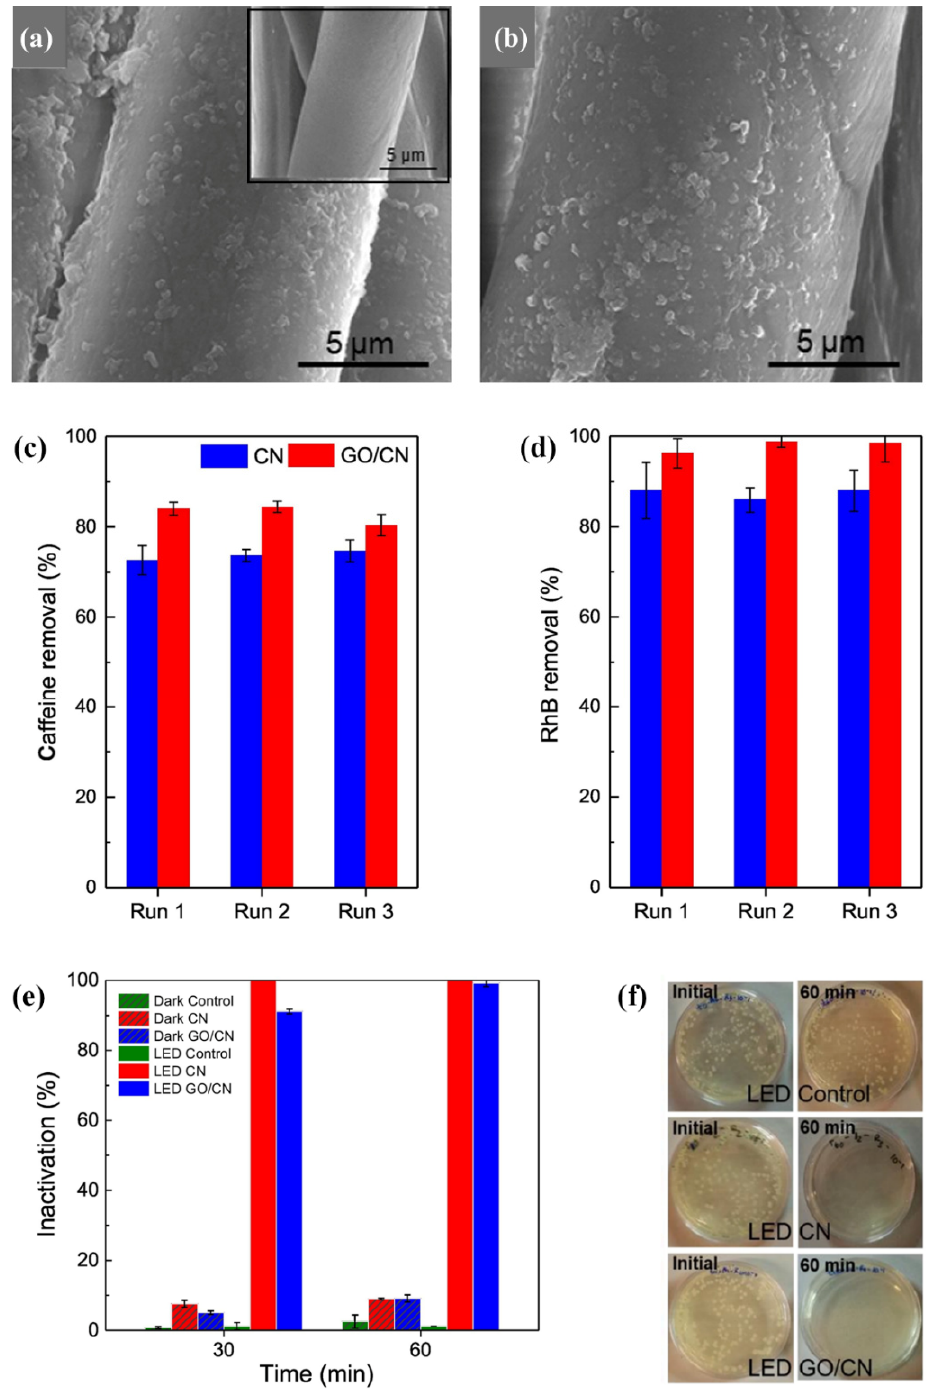
Figure 9. ( a , b ) SEM images of ( a ) g-C 3 N 4 (an insert uncoated sample) and ( b ) GO/g-C 3 N 4 coated cotton fabric samples. ( c , d ) Reusability assessment for the coated fabrics in the degradation of caffeine ( c ) and RhB ( d ) after a 240-min reaction. ( e ) E. coli inactivation with g-C 3 N 4 and GO/g-C 3 N 4 colloids and control experiments under visible light (LED) and dark conditions (dark). ( f ) Incubated agar plates inoculated with bacterial suspension and colloids or control before and after 60 min of LED irradiation. Reprinted with permission from [40]. Copyright 2019, Elsevier.